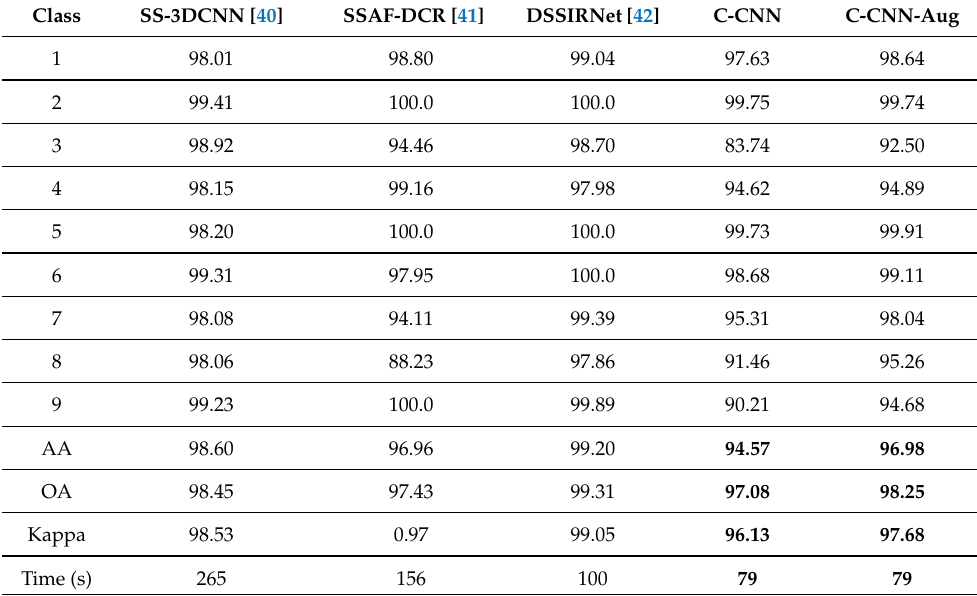
Table 5. The accuracy comparison of Pavia University classification.